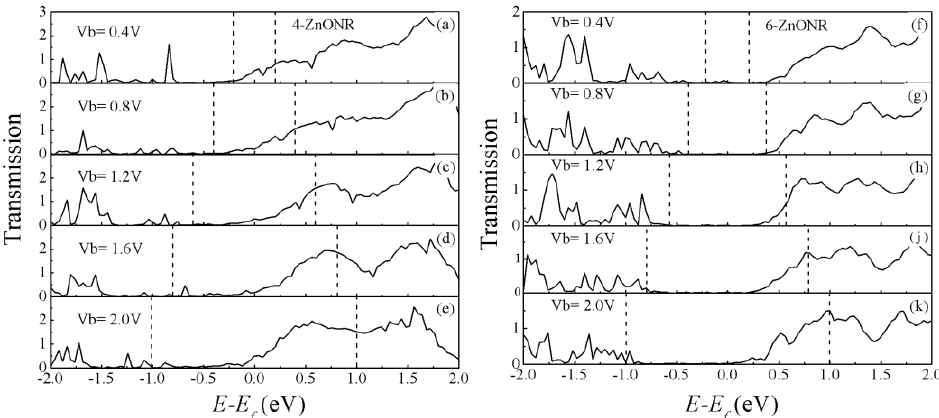
Figure 6. Transmission spectra of 4-ZnONR ( a – e ) and 6-ZnONR ( f – k ) devices under bias voltage. The dotted lines represent bias windows and the zero of the energy is set to Fermi level.